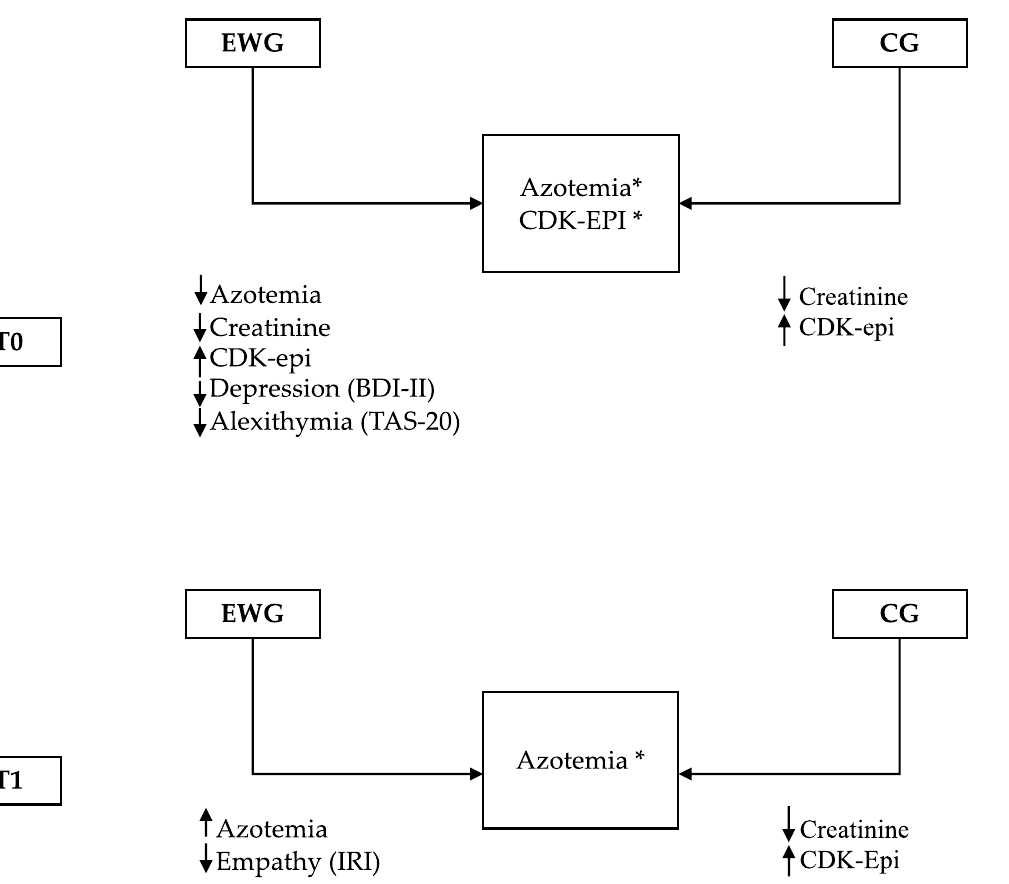
Figure 2. Significant differences between groups (*) and within groups on the investigated variables along the time frame.